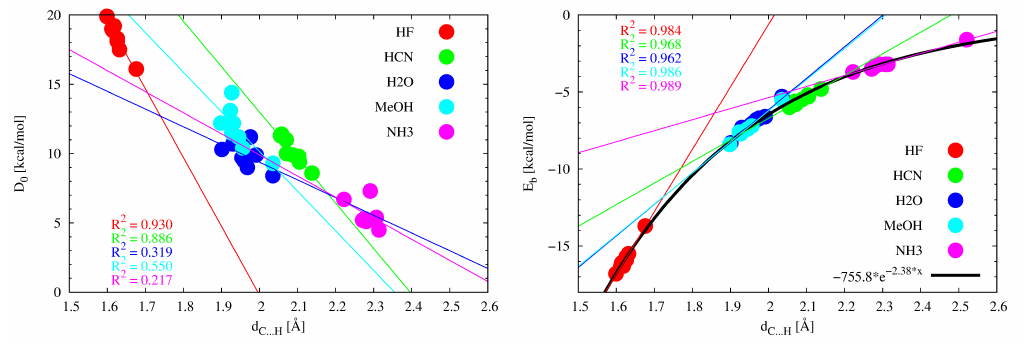
Figure 11. The dependence of either the dissociation energy ( left ) or the binding energy according to Equation (1) ( right ) on the distance C · · · H in the IR 2 · · · HD